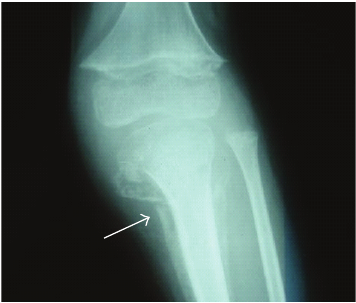
Figure 3: Radiograph of knee showing: an irregular thickened white line at the metaphysis of the femur, a small beak-like excrescences at the metaphysis of the femur, and a detachment of the periosteum of the